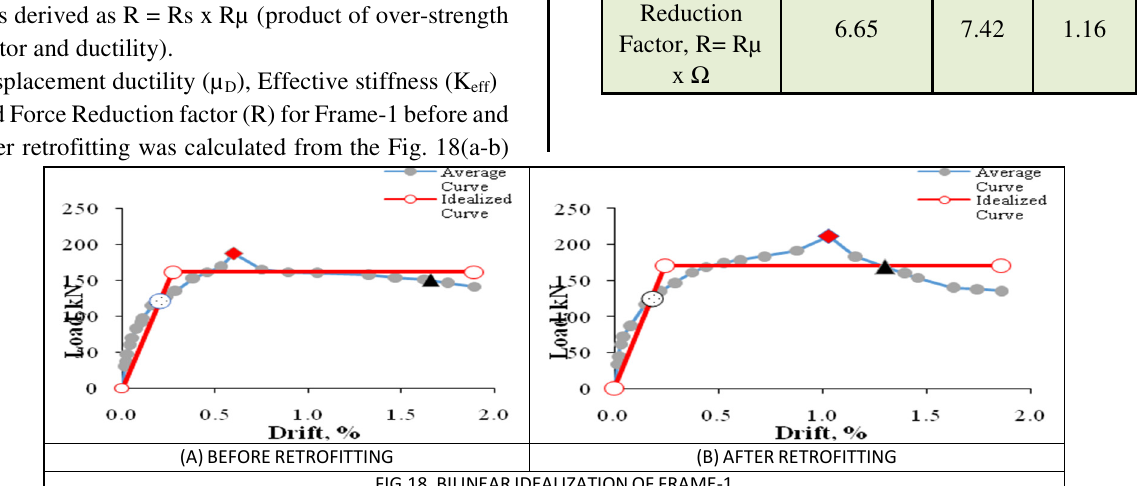
FIG.18. BILINEAR IDEALIZATION OF